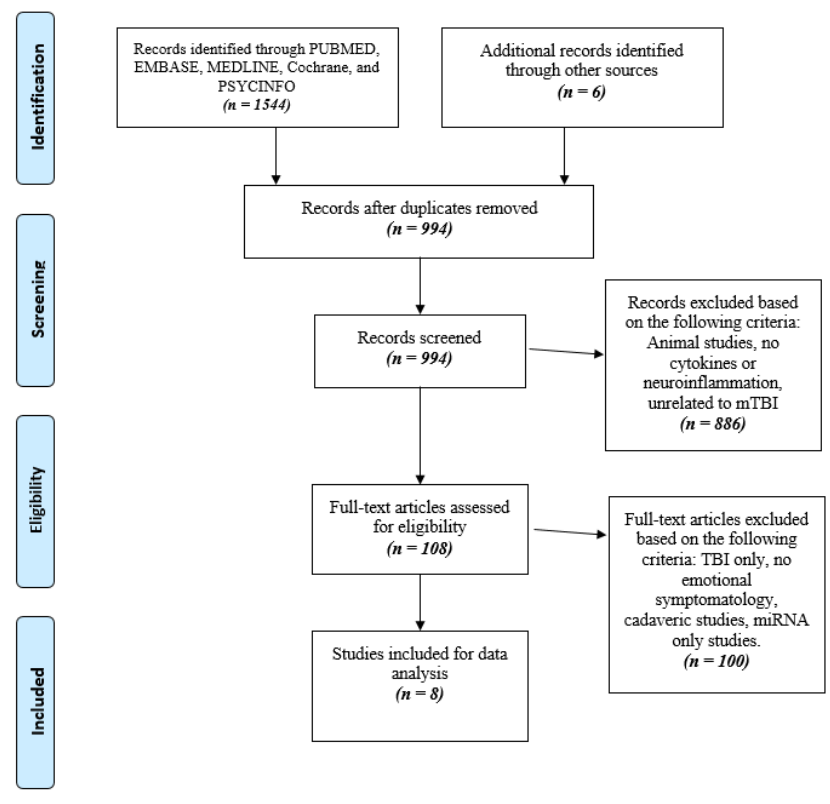
Figure 1. Prisma flow chart detailing the stages of study retrieval and